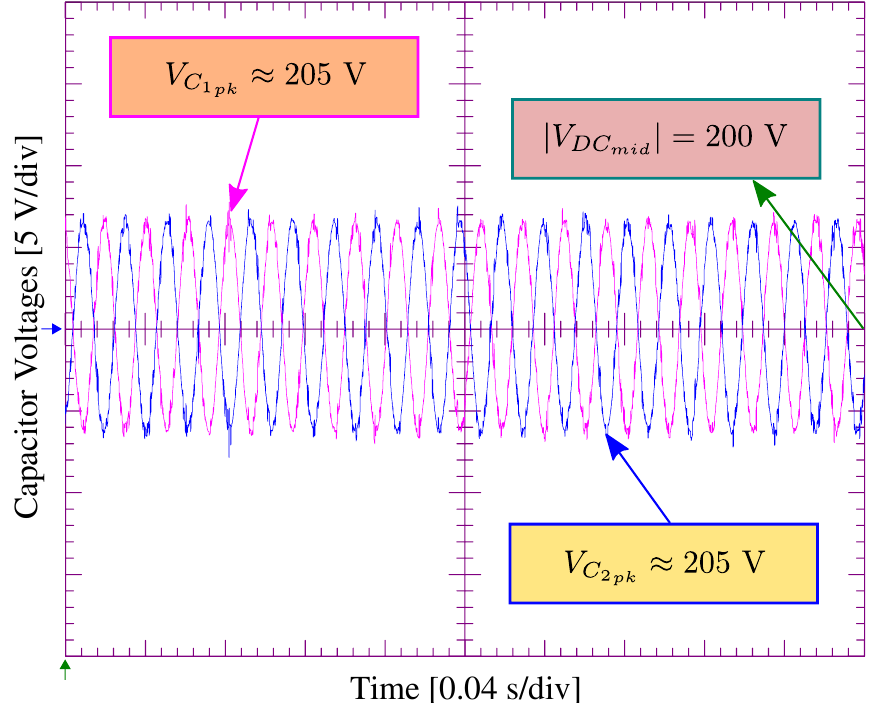
Figure 9. Steady-state DC-link capacitor voltages of the proposed zero angle LFS injection based PMSM drive with FSTP inverter. Operating at: 0.25 pu d -axis voltage and zero q -axis voltage with 10 kHz switching frequency under fan type loading